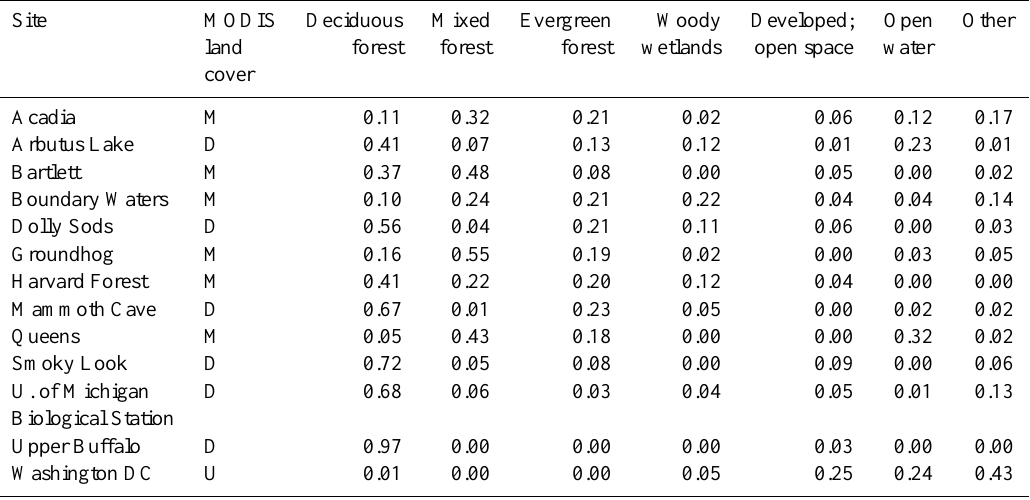
Table 1. Study sites with land cover characterization. Fractional coverage of each land cover type was calculated from the NLCD (National Land Cover Database) for study sites located in the US, and EOSD (Earth Observation for Sustainable Development of Forests) for sites located in Canada. “Other” includes shrub/scrub, developed; low intensity, developed; medium intensity, developed; high intensity, grass- land/herbaceous, emergent herbaceous wetlands, pasture/hay, and barren land (rock/sand/clay). MODIS land cover product classification: D – deciduous forest, M – mixed forest, and U – urban.